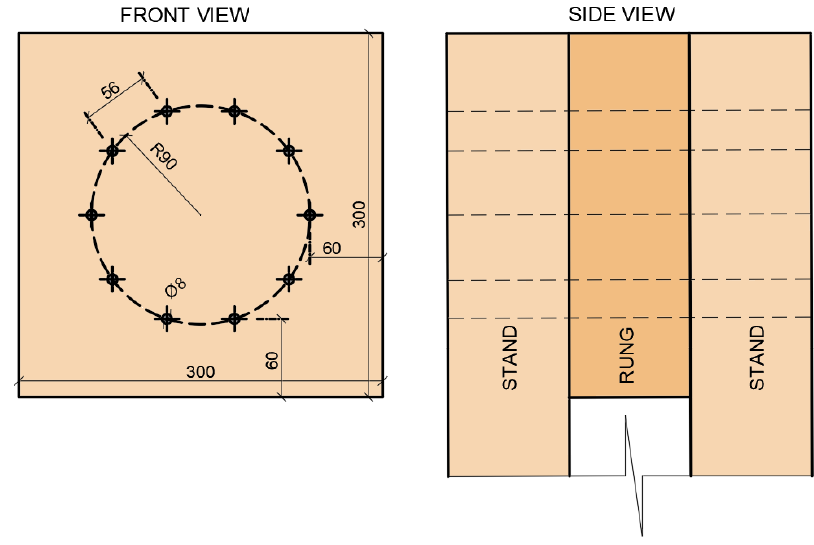
Figure 1. A location of fasteners in test specimens.